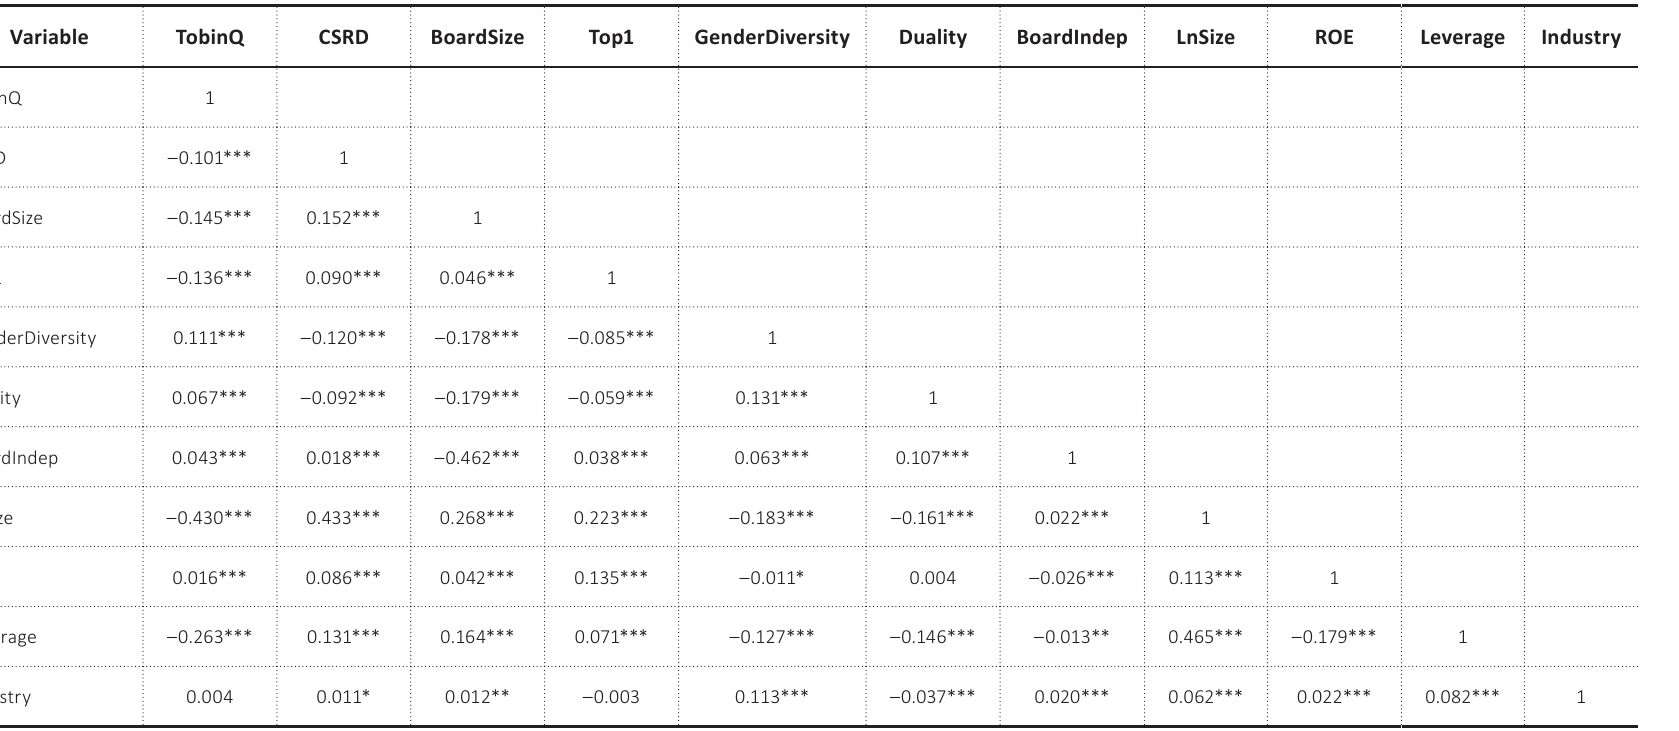
Table 5. Pearson correlation